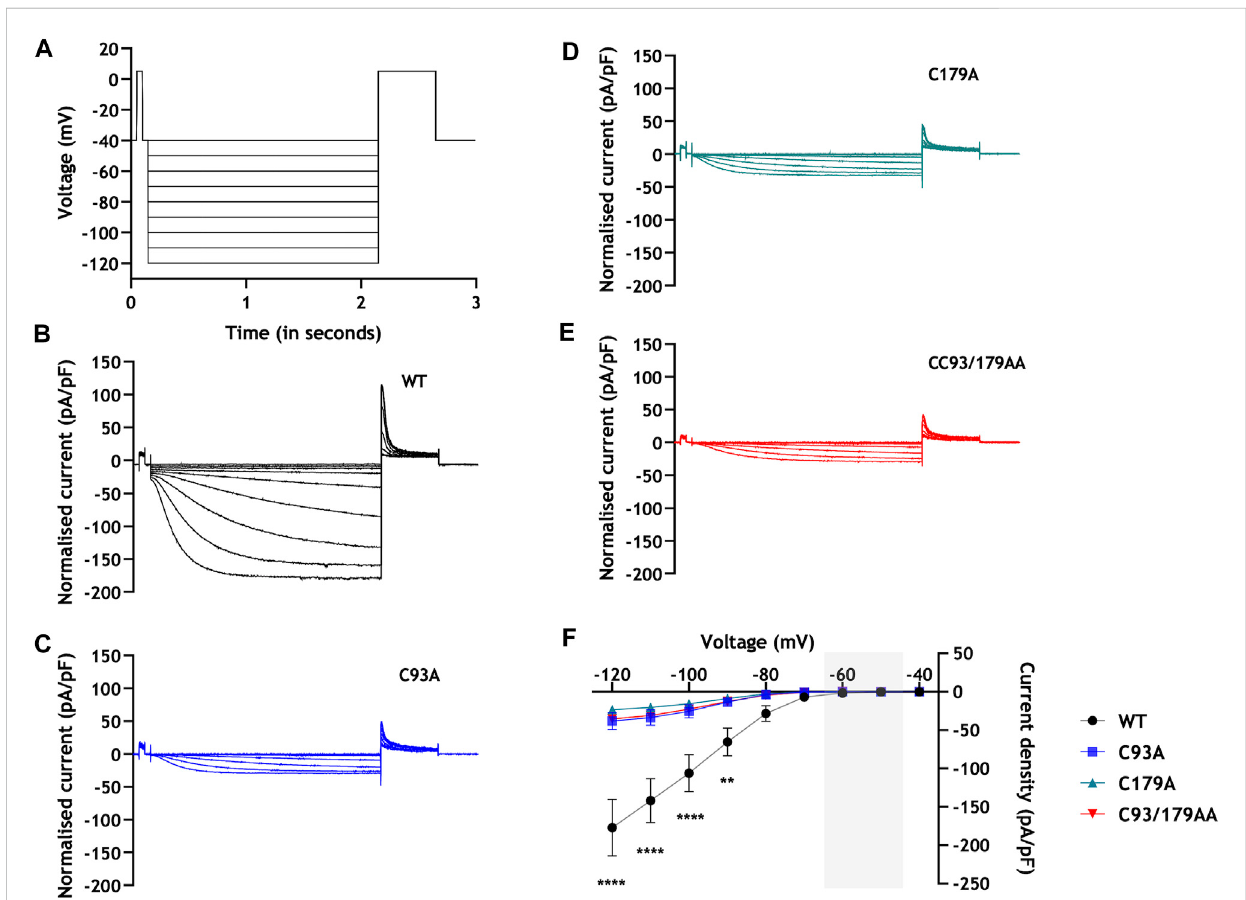
PalmitoylationandHCN4currents:current-voltagerelationships. (A) Voltageprotocol.Twosecondhyperpolarisingvoltagestepsweremadefroma holdingpotentialof − 40 mV.B-E:RepresentativefamiliesofcurrentsfromcellsstablyexpressingWT (B) ,C93A (C) ,C179A (D) andCC93/179AA (E) HCN4. (F) The averagesteady-statecurrent-voltage relationshipfrom293TcellsstablyexpressingWT (black), C93A(blue), C179A (green)andCC93/179AA(red) HCN4.Thesinoatrialdiastolicdepolarisationvoltagerangeishighlightedingrey.**, p < 0.01;****, p < 0.0001(two-wayANOVAfollowedbyTukey ’ s post hoc comparison); n =